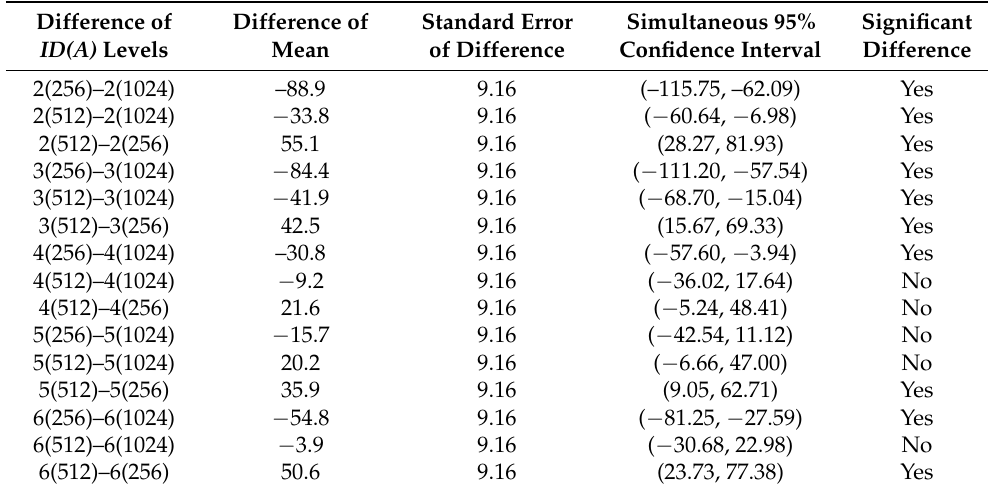
Table 3. Dunn–Šid á k simultaneous test for the planned contrasts (individual confidence level = 99.66%), indicating that most tasks with the same ID do not have identical MT .